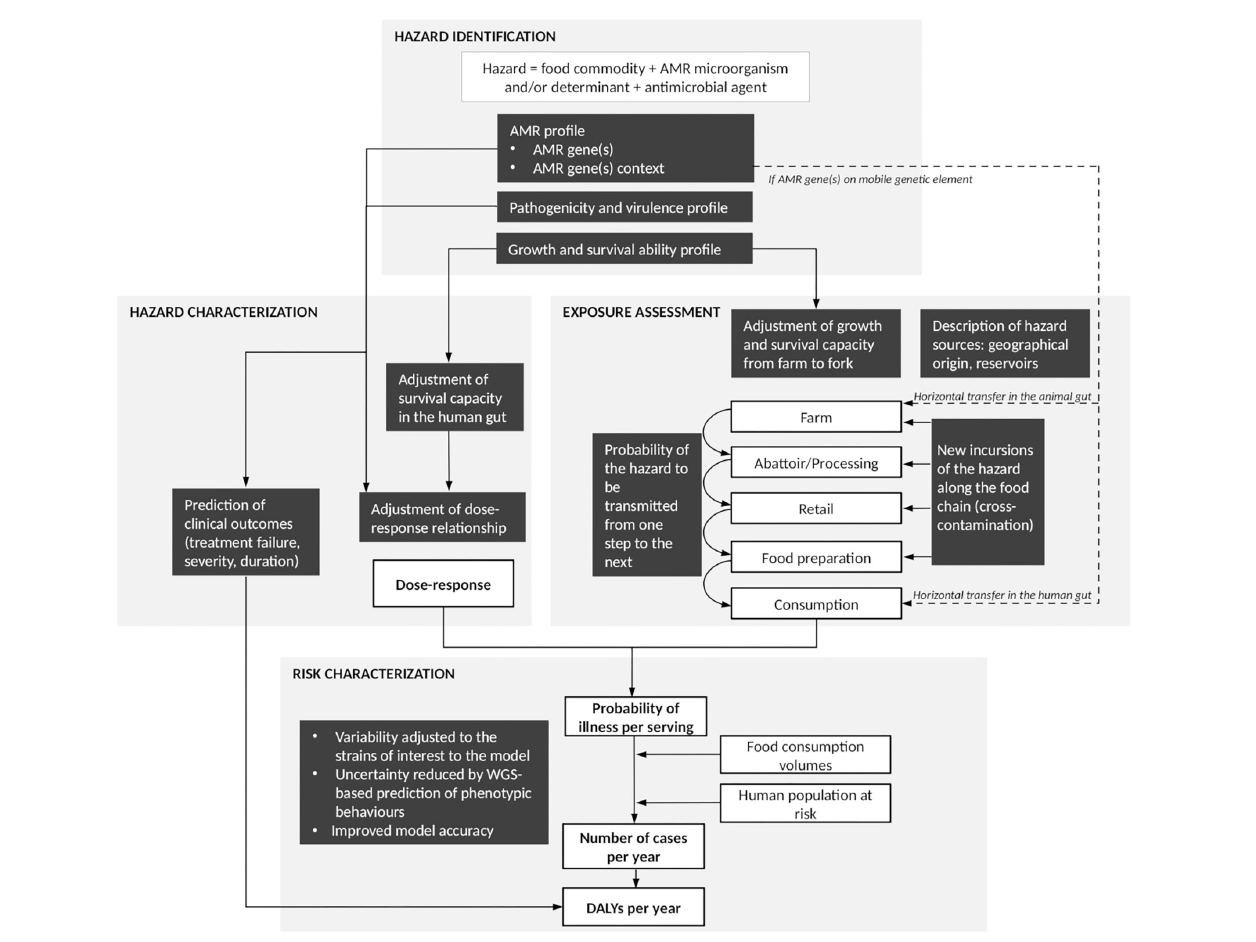
FIGURE 1 | Summary figure of the steps at which whole-genome sequencing (WGS) can contribute to improve quantitative microbial risk assessment (QMRA) of foodborne antimicrobial resistance (AMR). White boxes represent steps of a farm-to-fork risk assessment as conventionally recommended by the Codex Alimentarius Guidelines (Codex Alimentarius, 2011). Black boxes highlight areas where additional pieces of information may be provided by WGS data analysis. Solid arrows: direct connections between elements of the QMRA. Dash arrows: additional connections to be considered in cases where AMR is addressed as an indirect hazard (European Food Safety Authority [EFSA],